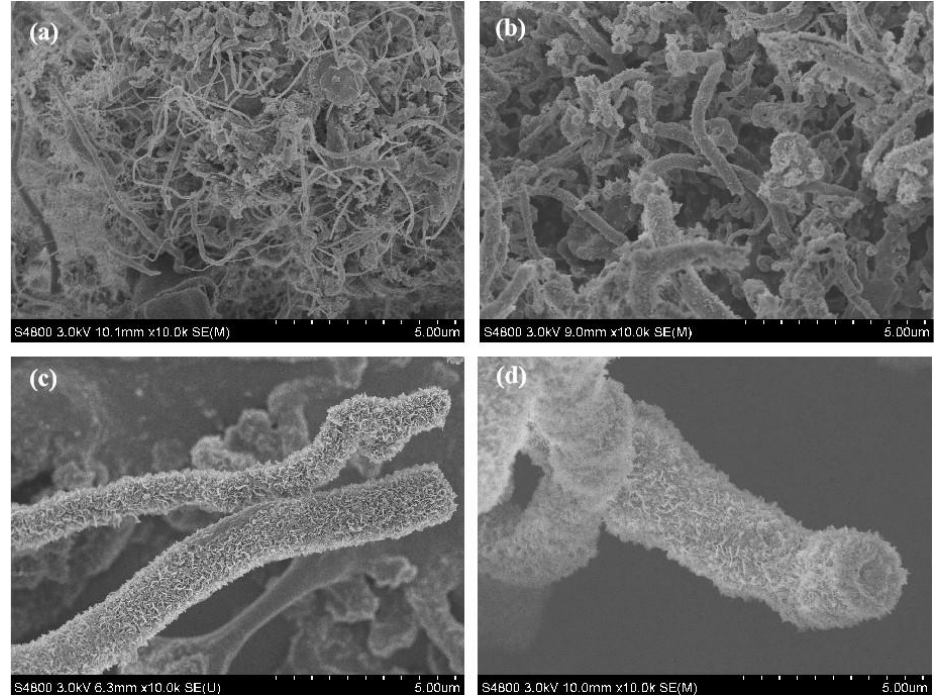
Figure 6. SEM images of the sample annealed at 1200 °C for different times: ( a ) 0.5 h, ( b ) 1 h, ( c ) 2 h, ( d ) 4 h.